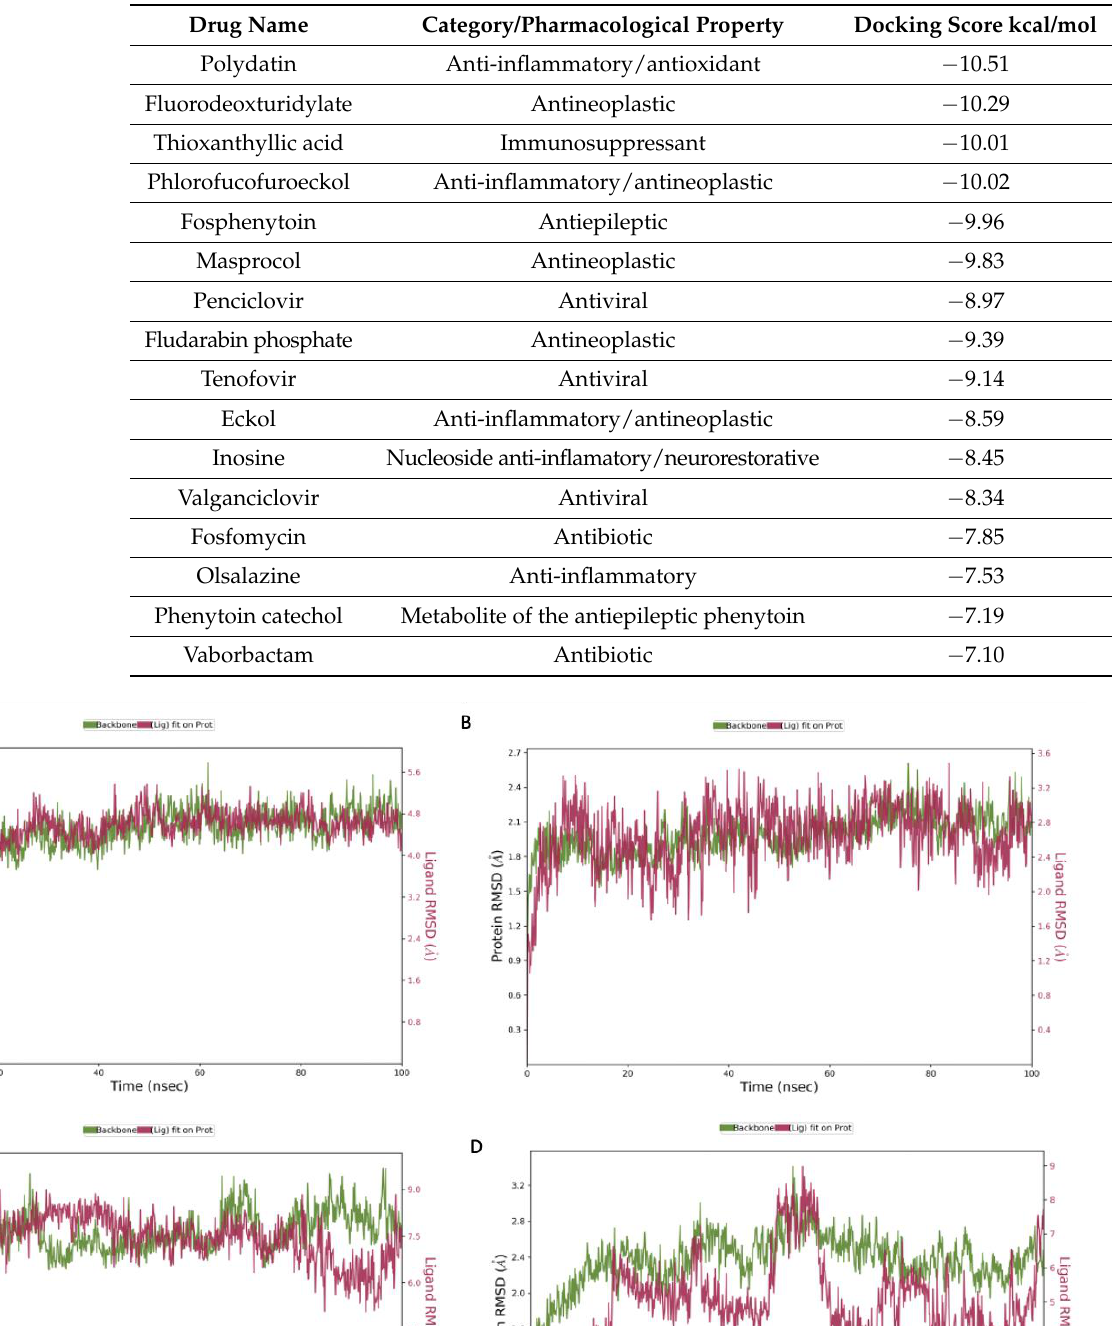
Table 1. Docking scores of identified hit compounds screened against the GCH1 active site.